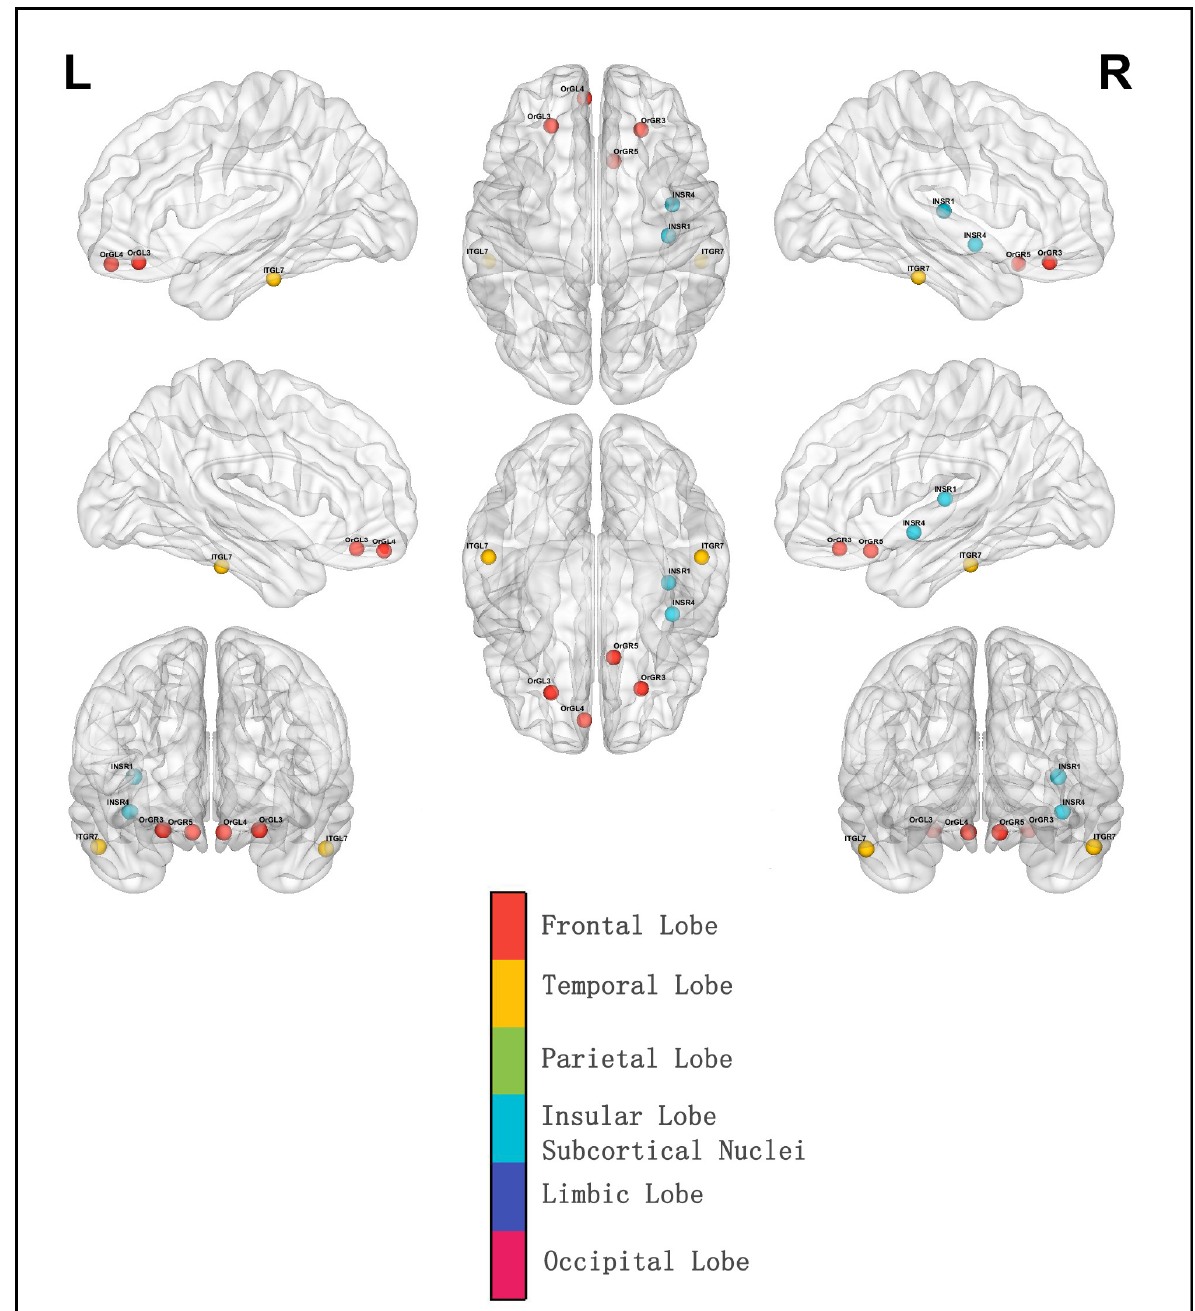
Figure 5. ROIs selected based on sFC strength feature intersection projected onto a standard brain surface. brain